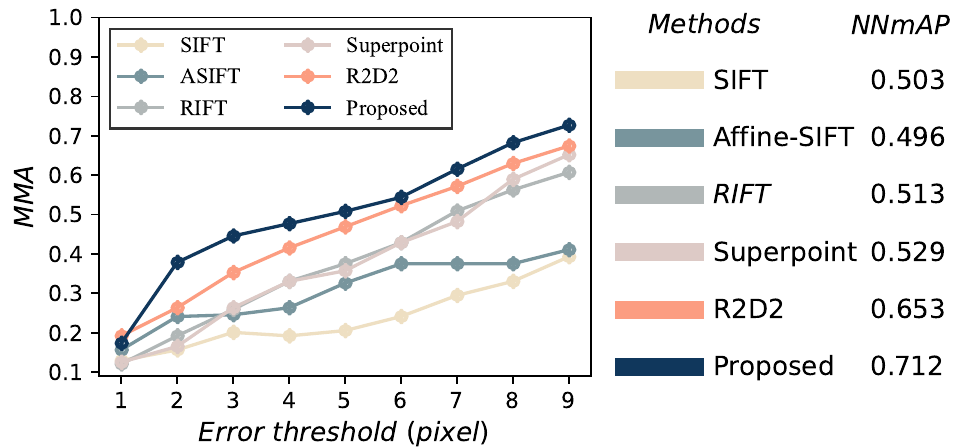
Figure 9. Comparison of different error thresholds using MMA and NN mAP evaluation results, where the comparison methods include SIFT, Affine-SIFT, RIFT, Superpoint and R2D2. The abbrevia- tion for Affine-SIFT is